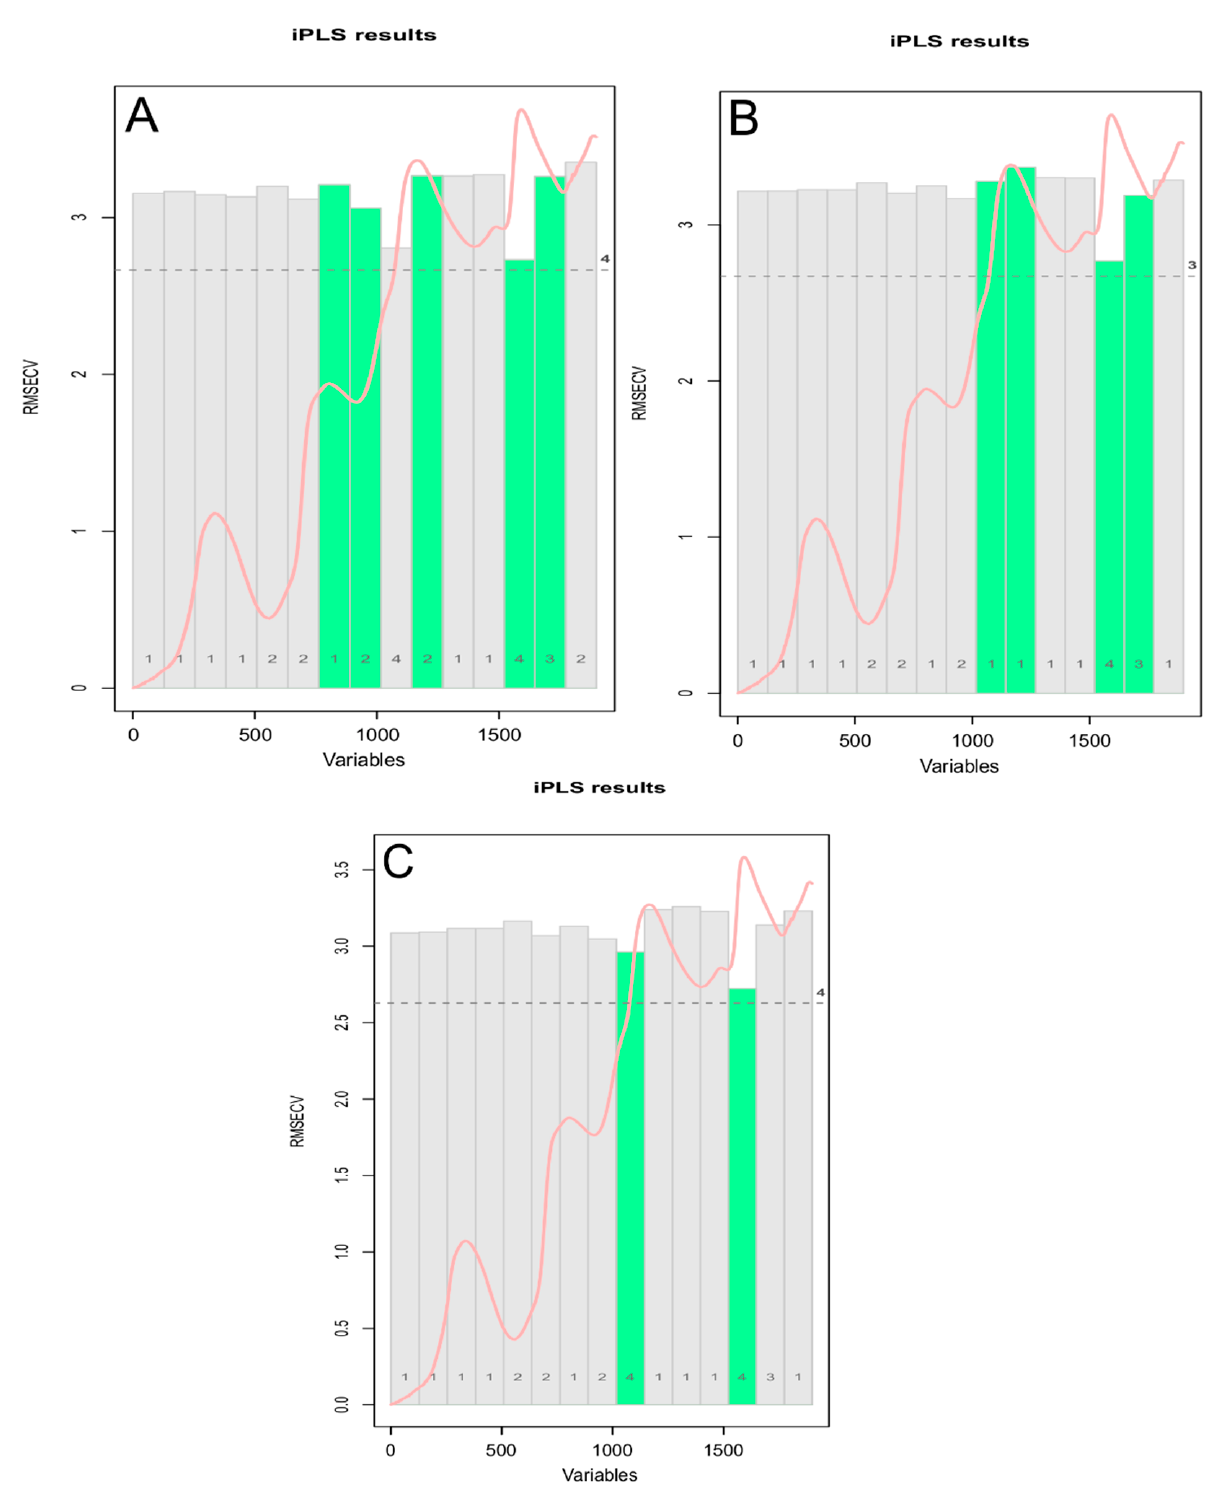
Figure 12. Selected intervals (in green) for iPLS models for “hardness” data—( A ) for all spectra of the training set, ( B ) after PCA outliers removal, and ( C ) after extreme spectra removal.